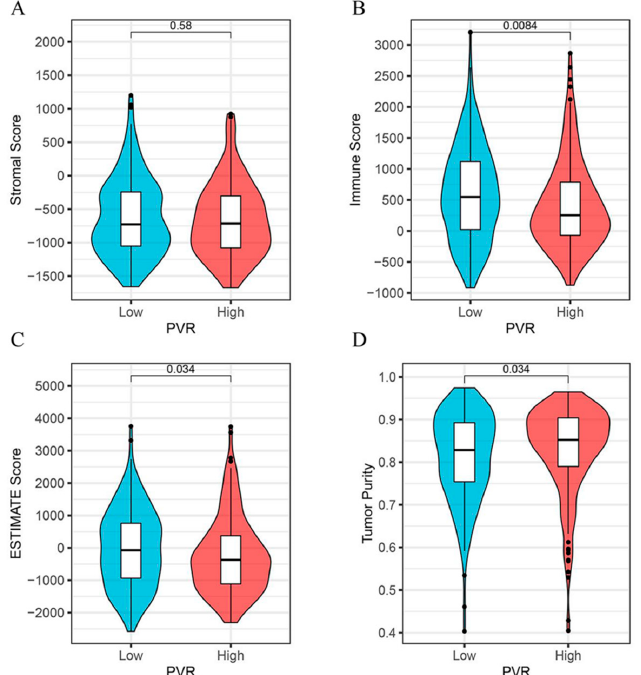
Figure 5. Correlation analysis between the PVR and immune scores. ( A ) The correlation between high and low PVR expression and stromal score. ( B ) The correlation between high and low PVR expression and immune score. ( C ) The correlation between high and low PVR expression and esti- mate score. ( D ) The correlation between high and low PVR expression and tumor purity.